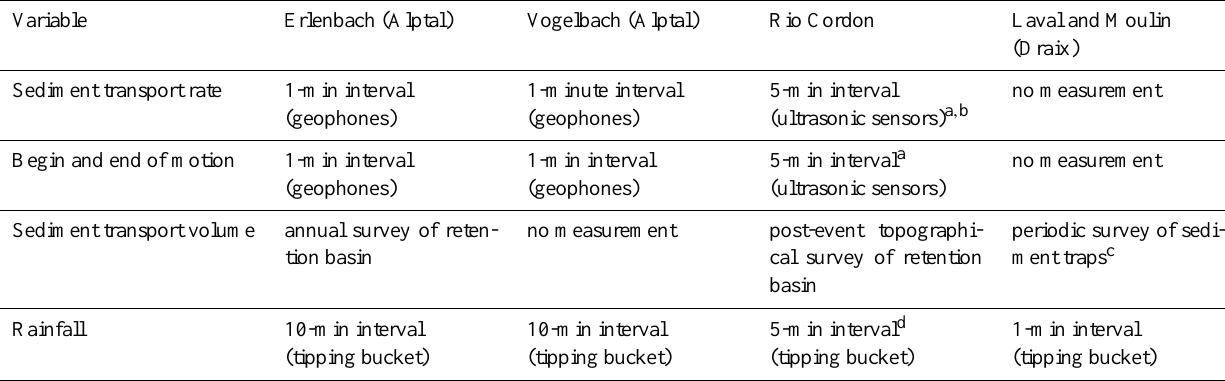
Table 2. Data acquisition at the different experimental sites.